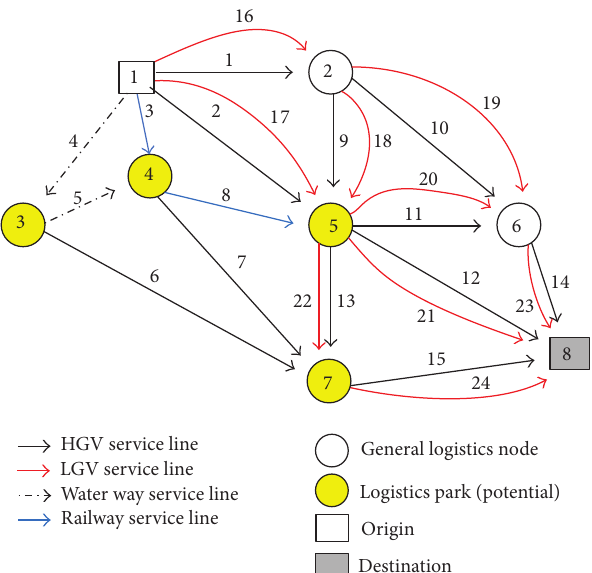
Figure 6: The modified logistics service network.